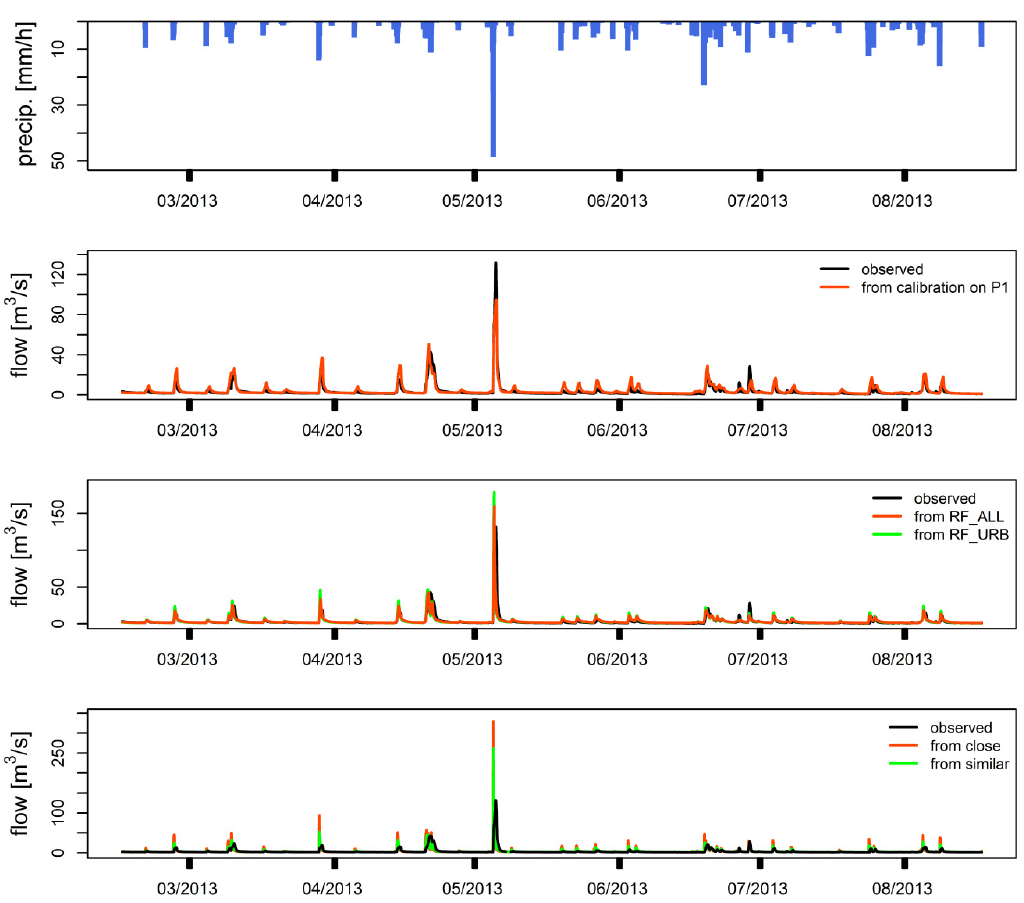
Table 3 details the values of the five sets of parameters used to compute these hydrographs: estimated from RF_ALL and RF_URB, transferred from calibration over the catchment’s first period P1, and transferred from the closest catchment (Dick Creek at Old Atlanta Road, near Suwanee, Georgia, USGS code: 02334620, area: 17.8 km 2 , mean CPD: 55.3%) and the most similar catchment